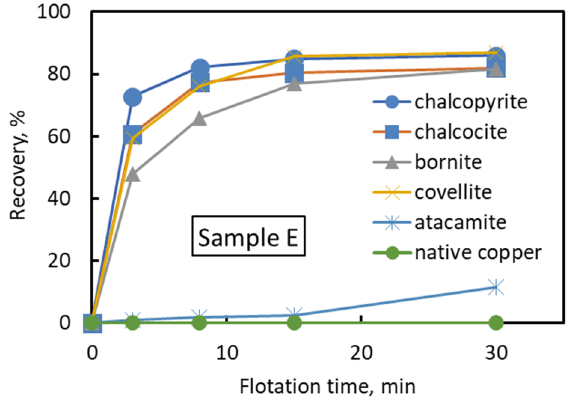
Figure 5. Flotation recovery for each copper mineral (Sample E).